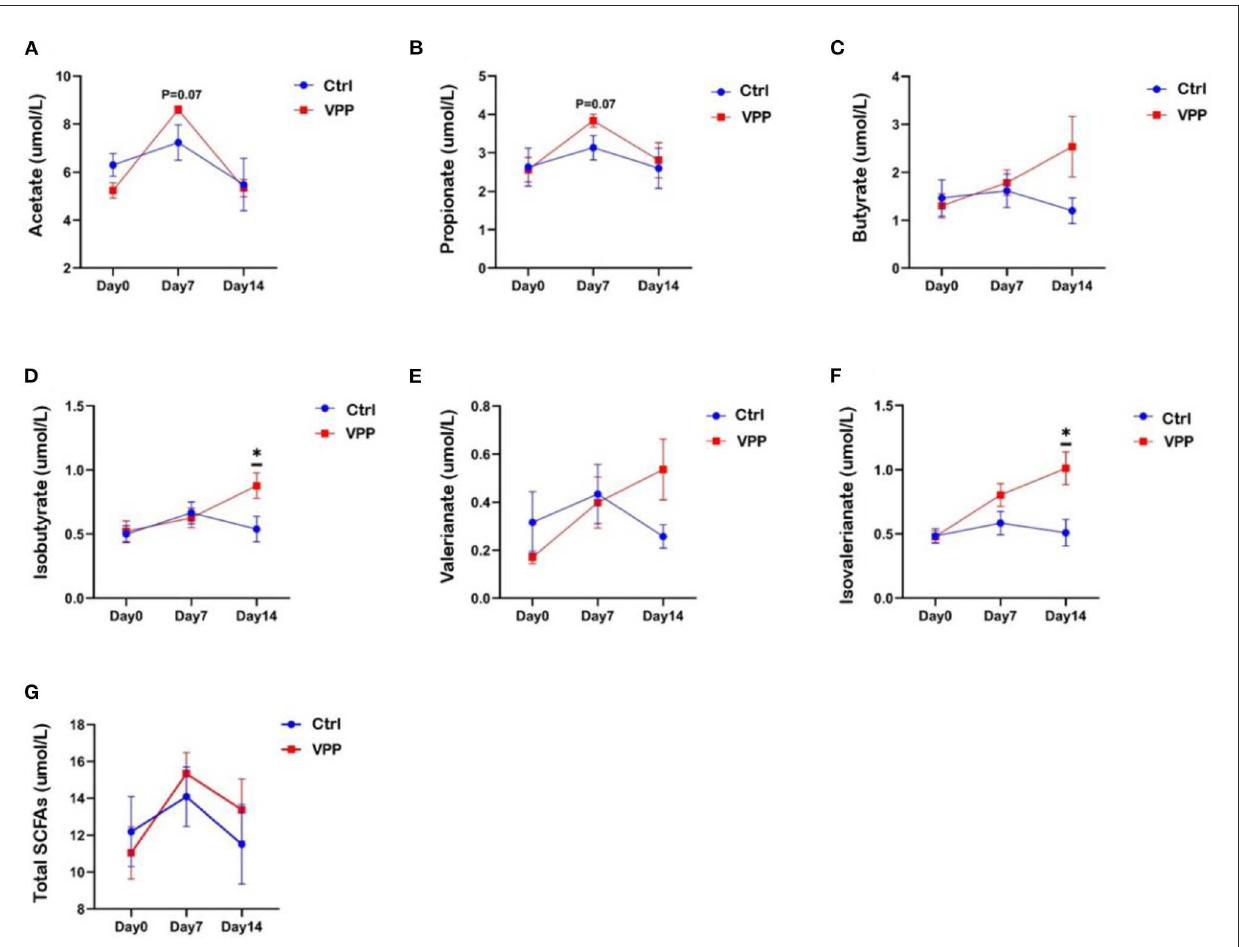
FIGURE3 Effects of VPP on short-chain fatty acids in pre-weaning calves. Concentrations of (A) acetate, (B) propionate, (C) butyrate, (D) isobutyrate, (E) valerianate, (F) isovalerianate, and (G) total short-chain fatty acids (SCFAs). Values are means ± SEM, n = 10. *Significant difference between group ( P <